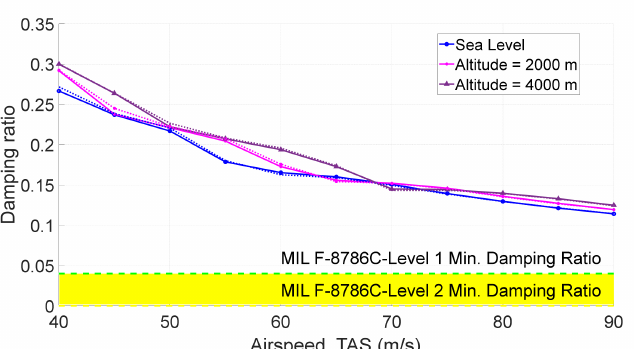
Figure 12. Damping ratio versus various airspeeds for phugoid mode; (solid lines account for the optimization using mass minimization scenario and dotted-lines are for drag optimization in trim flight).